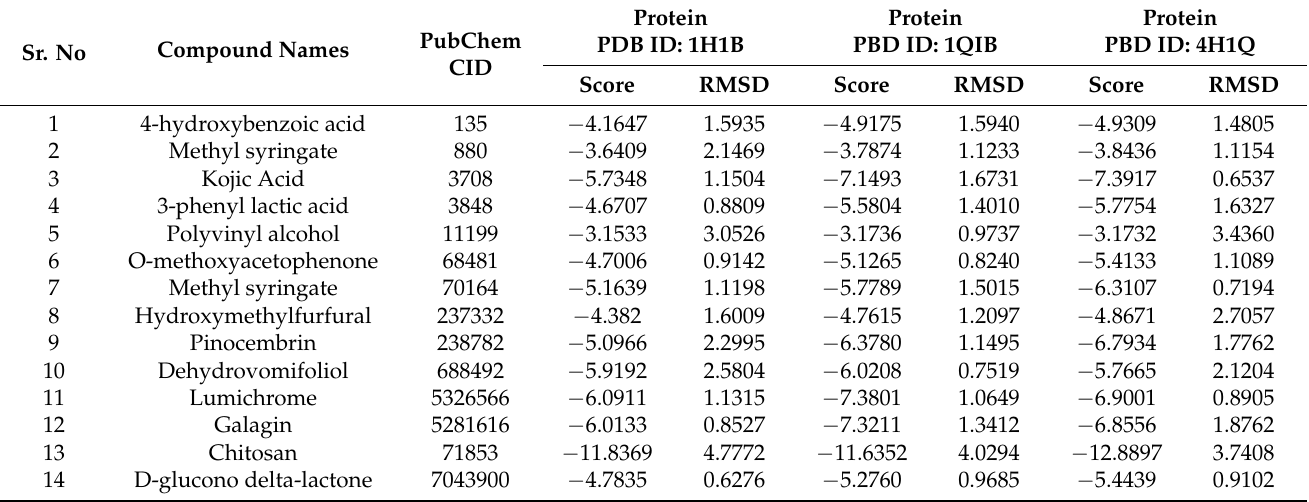
Table 5. Summary of molecular docking results performed by molecular operating environment